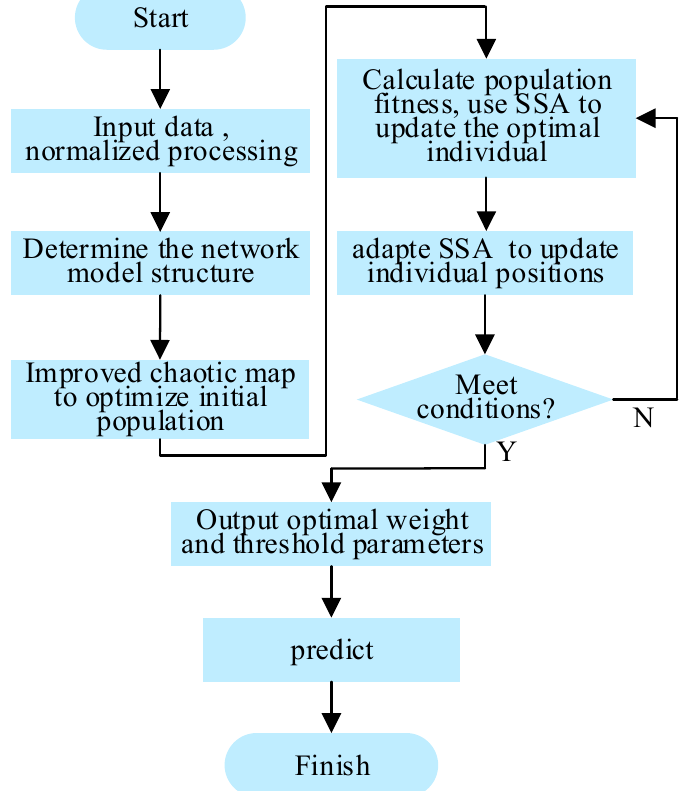
Figure 1. Flow chart of improved sparrow search optimization algorithm.